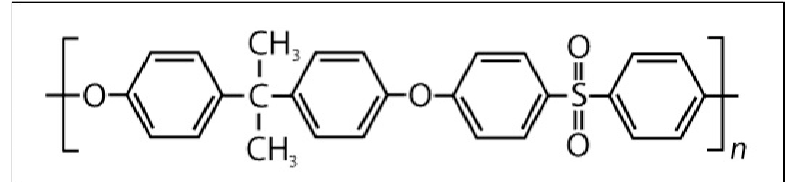
Figure 1. PSU repeating unit. Table 1. PSU